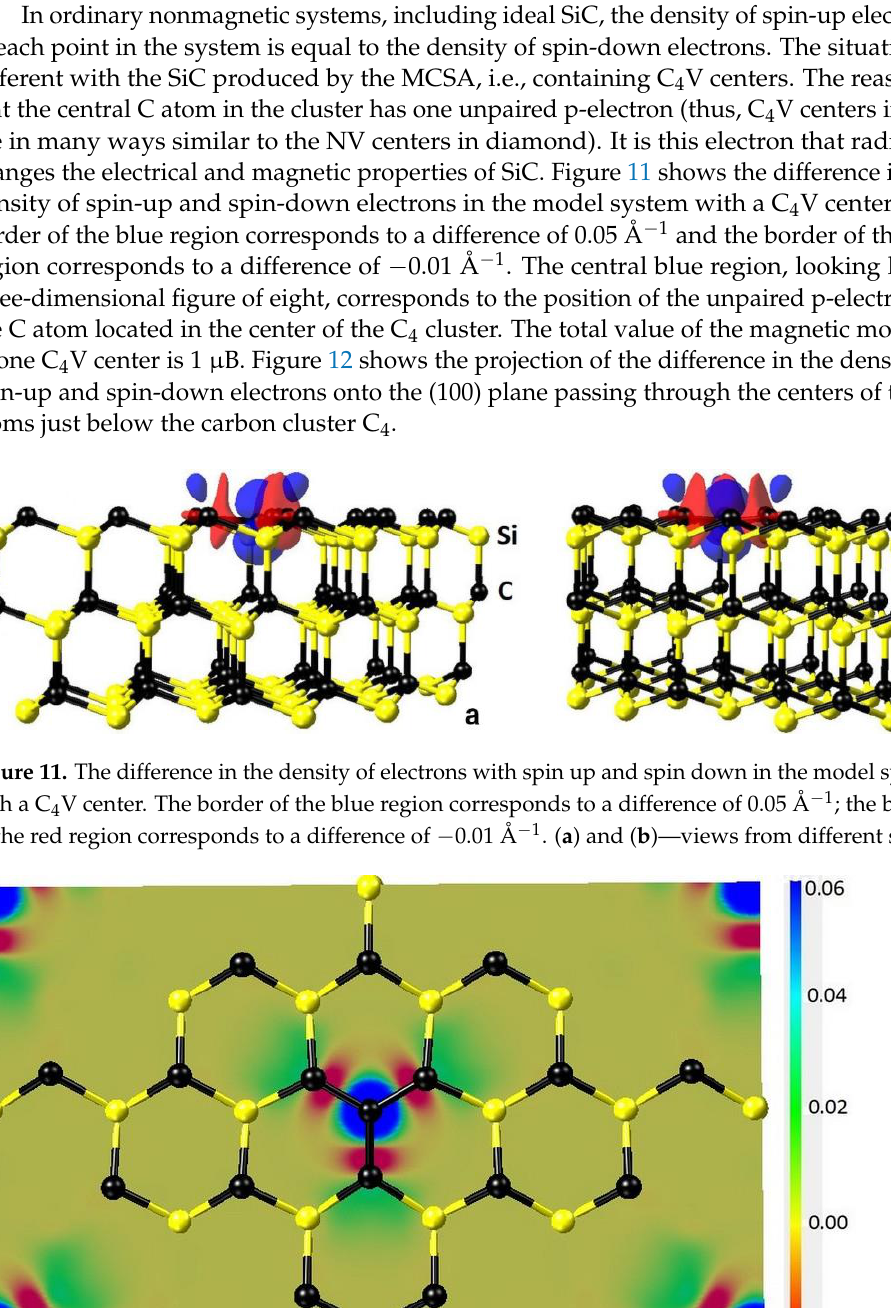
Figure 10. The stable state of a C 4 V silicon vacancy in p-type 3C-SiC (or intrinsic), consisting of an almost flat cluster of 4 C atoms and a void shown as a semi-transparent red sphere. ( a )— view in the direction <011>, ( b )—view in the direction <100>.